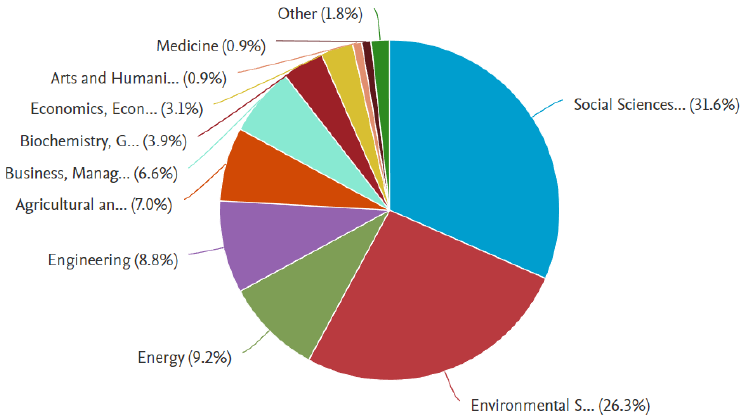
Figure 5. Number of documents per theme. Source: